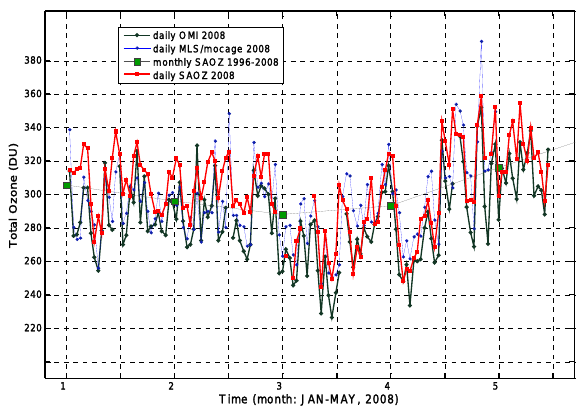
Fig. 2. Time evolution of total ozone derived from daily SAOZ observations (red line), from 1 January to 15 May 2008. The grey line with large square symbols represents the corresponding monthly climatological total ozone values derived from daily SAOZ observations at Kerguelen over the 1996–2008 period. The black solid line depicts the Aura/OMI daily values; while the blue solid line depicts the Aura/MLS values for Kerguelen assimilated by the MOCAGE-PALM system (from 1 January to 30 April 2008).